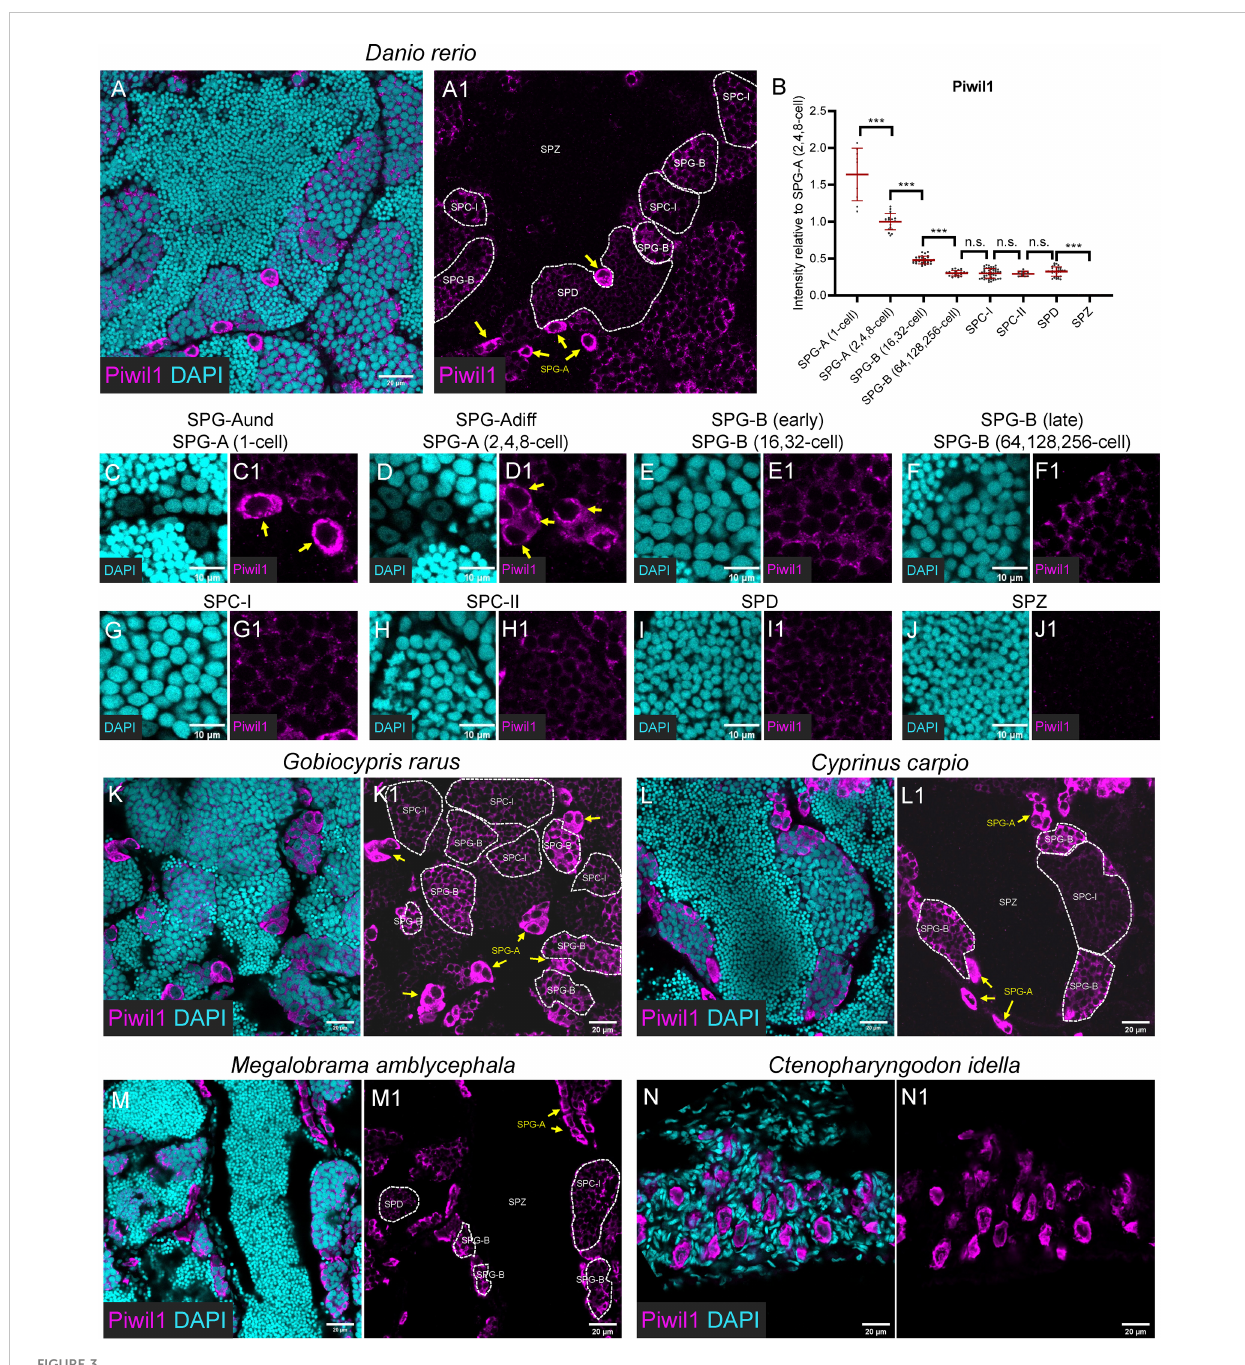
FIGURE 3 Piwil1 was highly expressed in the SPG-A, and expressed in the SPD but not in the SPZ. (A, A1) Representative images of a zebra fi sh testis section showing the expression of Piwil1 (magenta) co-stained with DAPI (cyan). (B) The graph showing the Piwil1 intensity of different types of spermatogenic cells relative to that of the SPG-A(2,4,8-cell). (C-J, C1-J1) The Representative images showing the SPG-A(1-cell) (E, E1) , the SPG-A (2,4,8-cell) (F-F1) , the SPG-B(16,32-cell) (G, G1) , the SPG-B(64,128,256-cell) (H, H1) , the SPC-I (I, I1) , the SPC-II (J, J1) , the SPD (K, K1) and the SPZ (L, L1) . (K-M, K1-M1) The representative images showing the expression of Piwil1 in Gobiocypris rarus (K, K1) , Cyprinus carpio (L, L1) , Megalobrama amblycephala (M, M1) and Ctenopharyngodon idella (N, N1) . SPG-As are indicated by the arrows, and other types of spermatogenic cells are circled by dashed lines. All data were collected from three independent testicular samples. All values are the mean ± STD. Unpaired and two-tailed Student ’ s t-test were used to compare means. ***P < 0.001, n.s. not signi fi